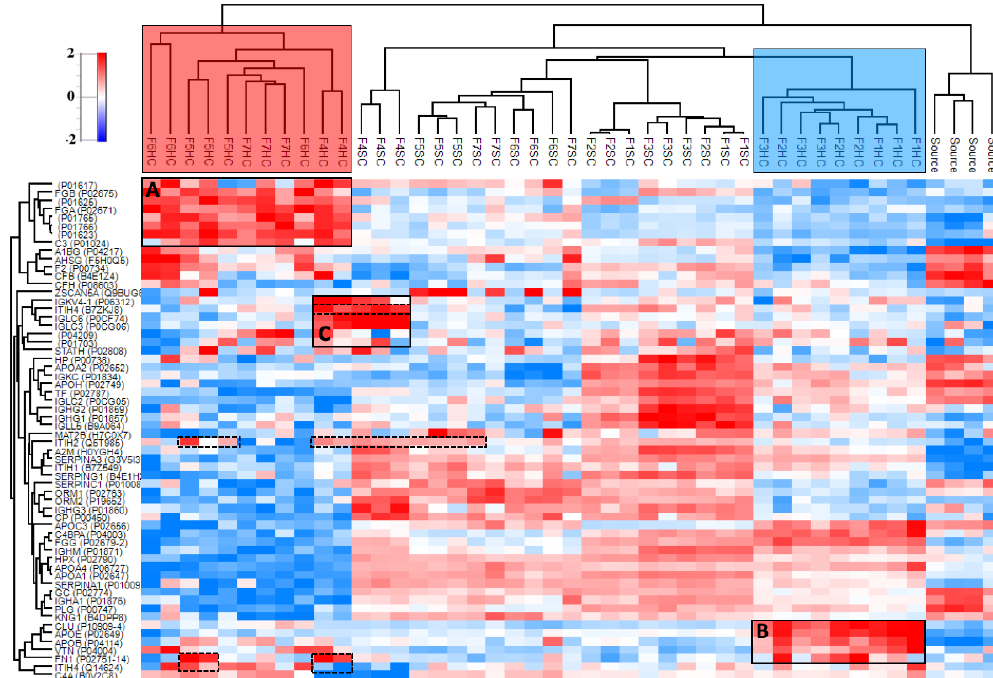
Figure 5. Heatmap of the top 60 most abundant proteins in at least three samples in human plasma after median normalization (178 proteins). Distinct clusters are observed for the HC, SC, and plasma source (including 1× and 7× diluted, surface plasmon resonance (SPR) instrument flow-through, and untreated). The HC subsections of the tested formulations cluster based on their anionic ( light-red box ) or neutral ( light-blue box ) surface charge. The corresponding significantly enriched proteins are highlighted with black boxes ( A – C ). The dashed boxes indicate the enrichment of hyaluronic acid-binding inter-alpha-trypsin inhibitor heavy chain proteins (ITIH2, ITIH4) and fibronectin (FN1). The range for relative enrichment ( red ) and depletion ( blue ) is two standard deviations from the mean on the log 2 scale.